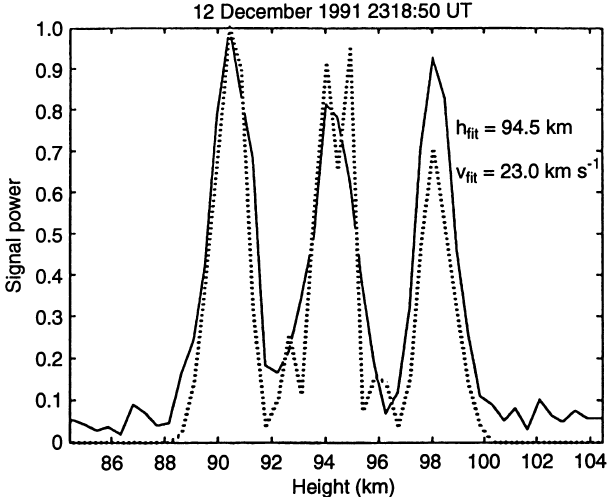
Fig. 8. An example of a velocity fit on a typical head echo event from the Geminid campaign in 1991. The measured data is shown in full line and the model fit in dashed line